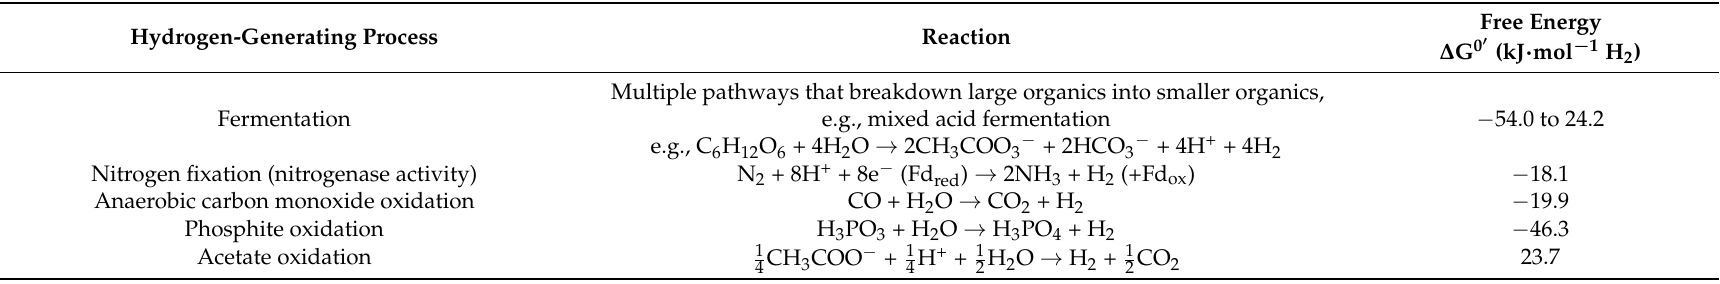
Table 2. Microbial hydrogen-generating reactions. Range of fermentation free energy of reactions from Reference [41], and adjusted to per mole hydrogen. Phosphite oxidation free energy from Reference [42]. All other free energies of reaction were calculated from thermodynamic data in Reference